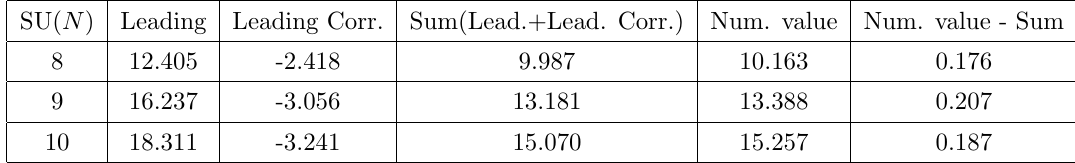
Table 14 . Comparison of N -ality 7 k -strings for SU(8